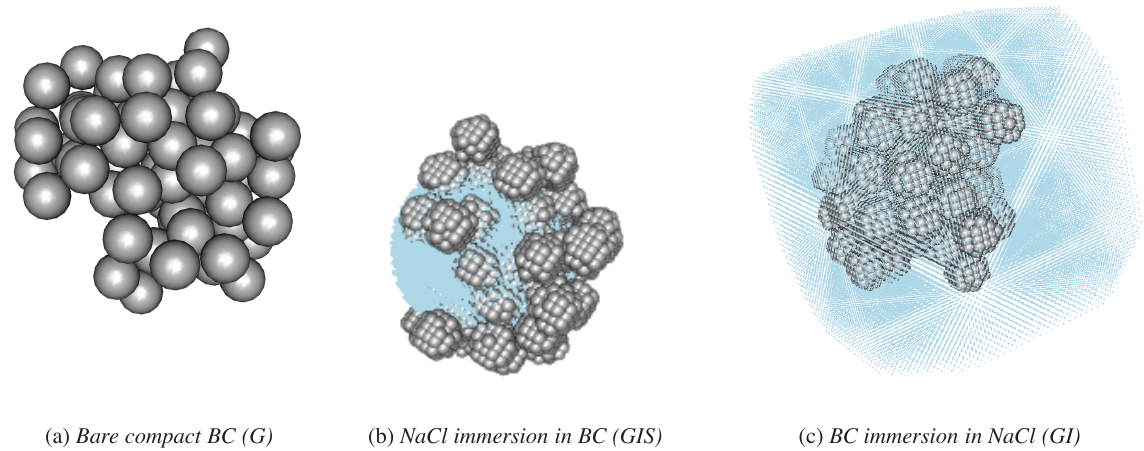
Fig. 6. Visual representation of modeled internal mixtures of compact BC aggregates and NaCl. (a) Case G is a bare compact BC aggregate. (b) Case GIS shows a compact BC with an “inclusion” of NaCl, while (c) case GI is a total inclusion of BC (lighter grey) in salt particle (light blue). The points in light blue are the dipoles representing NaCl, while the circles in light grey represent the dipole positions for BC. The dense number of dipoles finely characterizes the morphology of NaCl and of the BC aggregate.